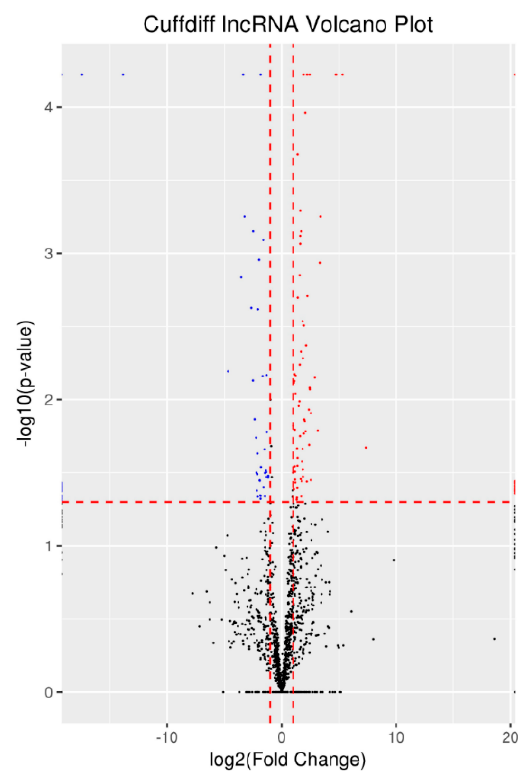
Figure 2. Differentially expressed lncRNAs. Note: The horizonal dashed red line shows criteria of P values equal to 0.05 while vertical dashed lines show log2FC equal to -1 (left) and 1 (right). The points colored with red and blue show the genes if they are upregulated and downregulated, respectively. Black points mean genes does not meet the significant criteria.3.5. Predication of the Targeted Genes.